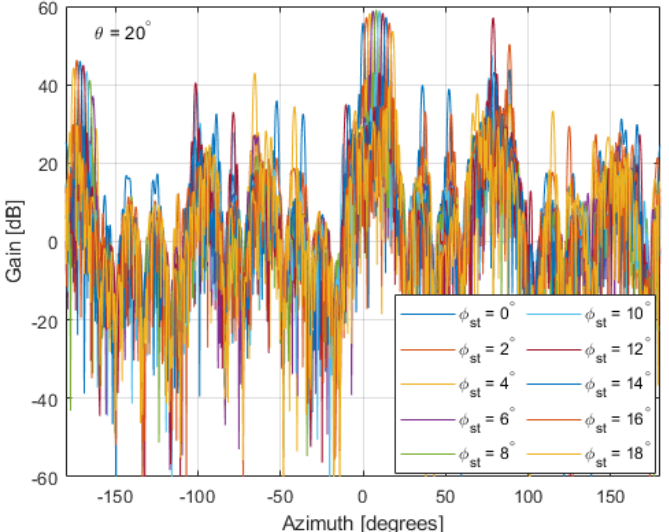
Figure 16. Horizontal cuts at 20 ◦ elevation of the beam patterns of the LOFAR station with the digital beams steered at different φ st and θ st = 20 ◦ .